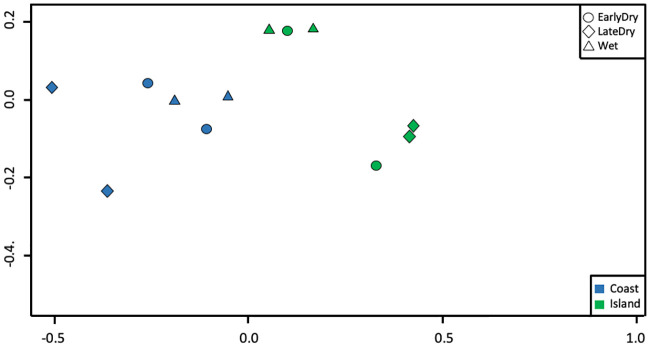
nMDS plot showing the grouping of sites and seasons.A clear separation of the islands site from the coast site was observed. Additionally, wet season sampling periods form a loose cluster separate from the dry seasons.